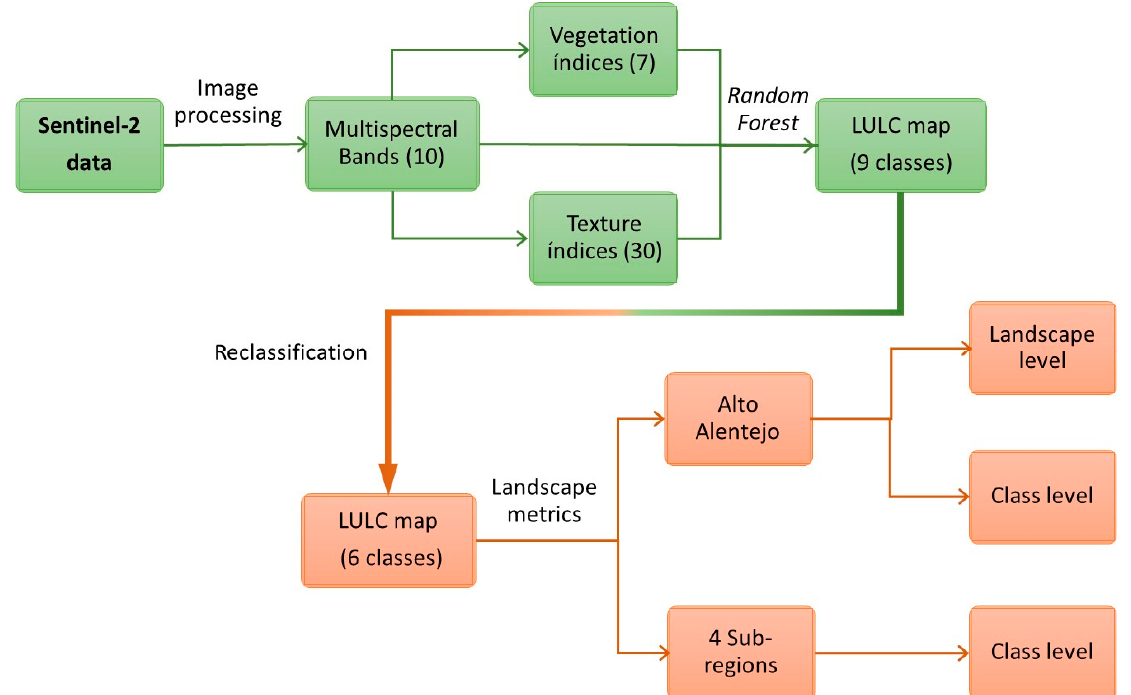
Figure 2. Flowchart of the methodology of this study.